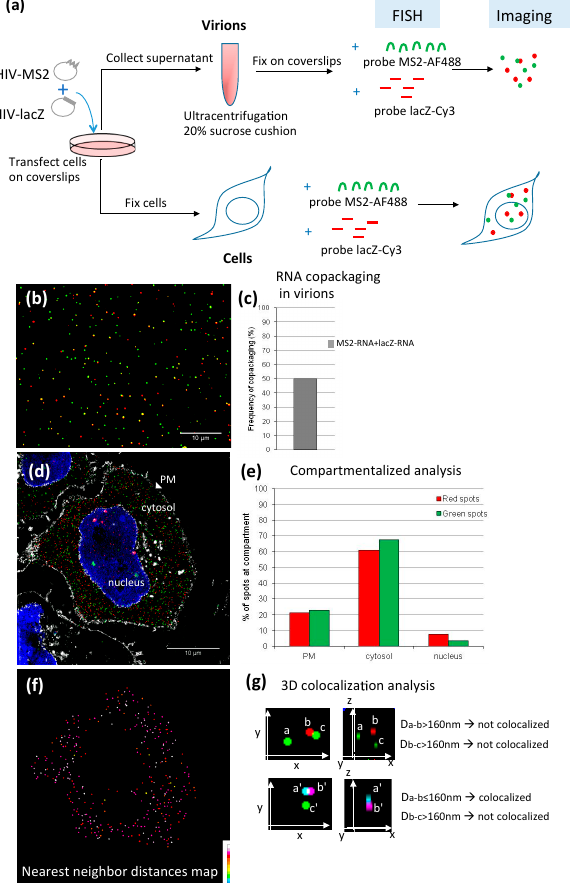
Figure 2. Dual-color imaging of RNA in cells and virus particles [15]. ( a ) Schematic representation of the methodology used. Cells are seeded on coverslips and transfected with plasmids encoding HIV-1 gRNA tagged either with 24xMS2 or a fragment of lacZ gene. Cell culture supernatants are collected and ultracentrifuged for viral particles concentration. A drop of virus-containing pellets are then allowed to settle down on coverslips and fixed for fluorescence in situ hybridization (FISH) labeling using specific probes targeting the tags. ( b ) Microscopic image of virions showing the MS2 and lacZ tagged gRNAs labeled in green and red, respectively. Colocalized spots appear in yellow. ( c ) Quantification of the percentage of virions harboring two distinctly tagged gRNAs. ( d ) 3D-structured illumination microscopy (3D-SIM) image of a cell transfected with HIV-MS2 and HIV-lacZ at 24 h post-transfection. HIV-MS2 and HIV-lacZ gRNAs are labeled in green and red by FISH, respectively. The nucleus is stained in blue using 4 (cid:48) ,6-diamidino-2-phenylindole (DAPI) and the cellular membranes are labeled with wheat germ agglutinin, Alexa Fluor 647 conjugate (WGA-647) and shown in white. ( e ) Quantification of the distribution of red/green spots in the different compartments of the cell shown in (d) (PM for plasma membrane). ( f ) Image of the same cell as in d showing red spots colored according to the 3D Euclidian distance of each spot to its nearest neighboring spot in the green channel. This way, colocalization between red-green spots can be calculated above a threshold distance, as shown in (g). ( g ) Example of colocalization analysis between spots of different colors in the 3D space. In the upper panels, two spots may appear colocalized in 2D ( x , y ) but not when depth ( z ) is considered. Two spots are colocalized when the 3D-Euclidian distance (D) is ≤ 160 nm, as in the panels